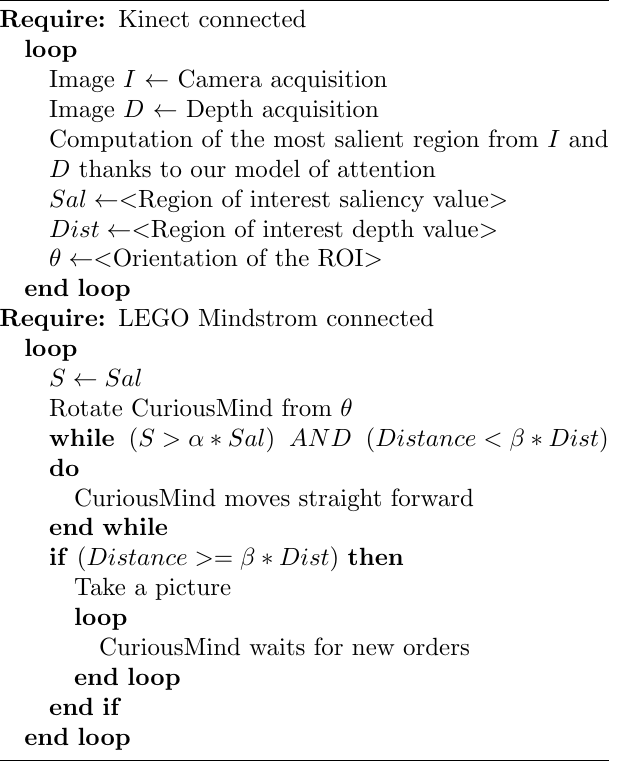
Figure 6. Block diagram of CuriousMind. Algorithm 1 Take a picture of the nearest salient object